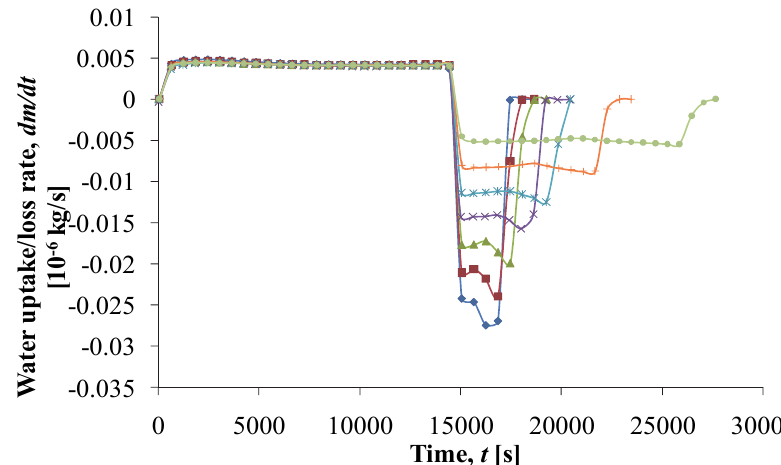
Fig. 10 Water uptake/loss rate of the sample of 12.92 mg of NaCl as a function of time at 25 ℃ : dissolution at 90% RH followed by recrystallization at 0% RH ( ◆ ), 10% RH ( ■ ), 20% RH ( ▲ ), 30% RH ( × ), 40% RH ( ), 50% RH ( + ) and 60% RH ( ●